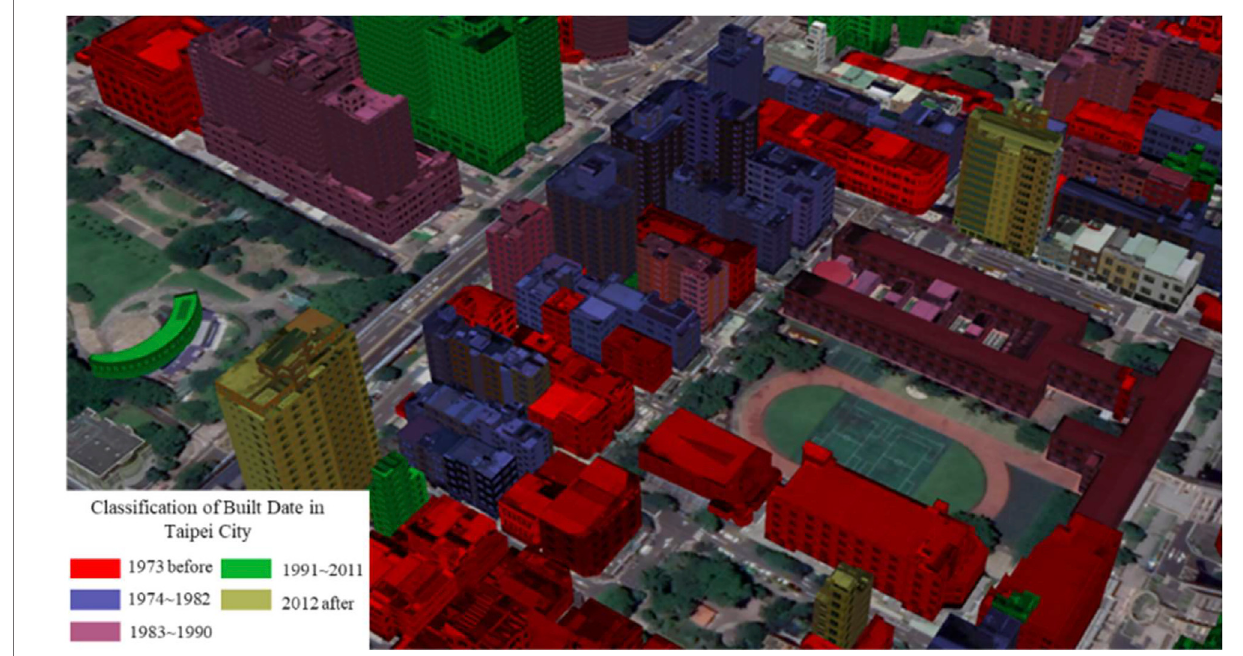
FIGURE 16 | Thematic map of building age in Taipei City.